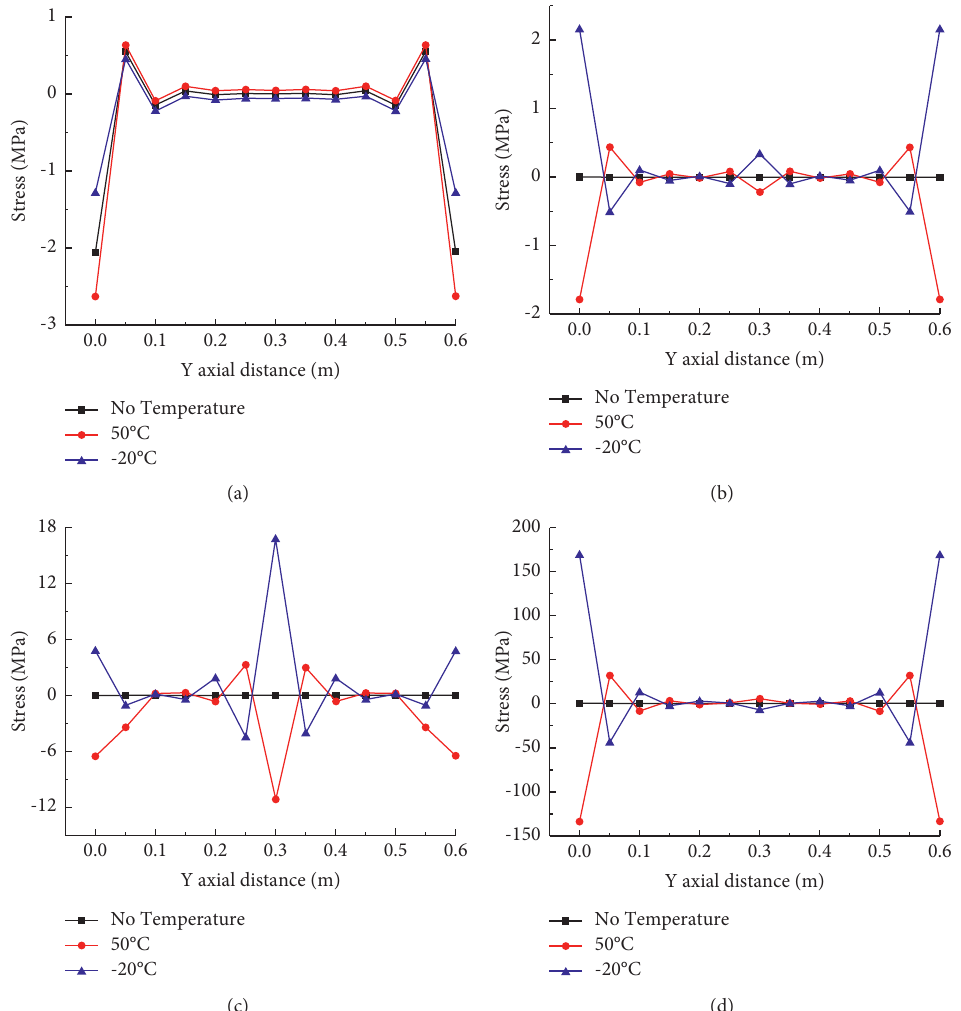
Figure 22: Comparison of normal bond stress of the semirigid finish layer. (a) Face brick. (b) Bonding layer. (c) Insulation layer. (d) Interface layer. Table 6: Mechanical performance test of the polymer mortar.